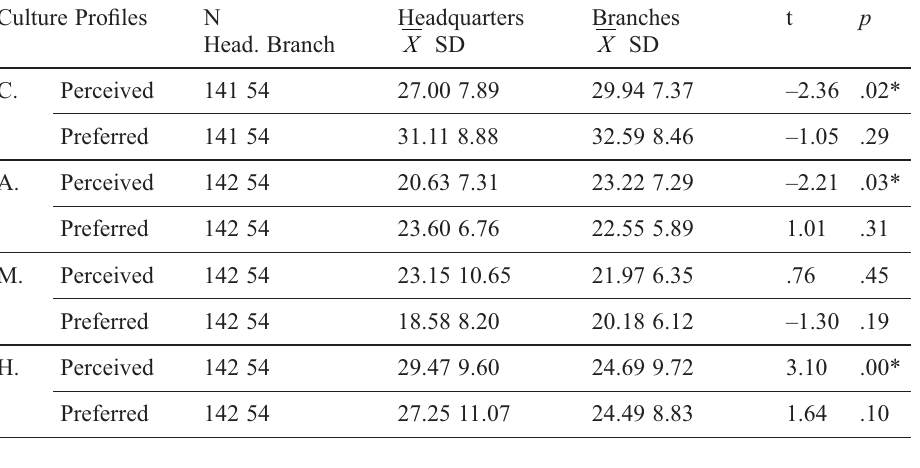
Table 3. Means, standart deviations, t and p values of culture profi les (* p < 0.05) Culture Profi les